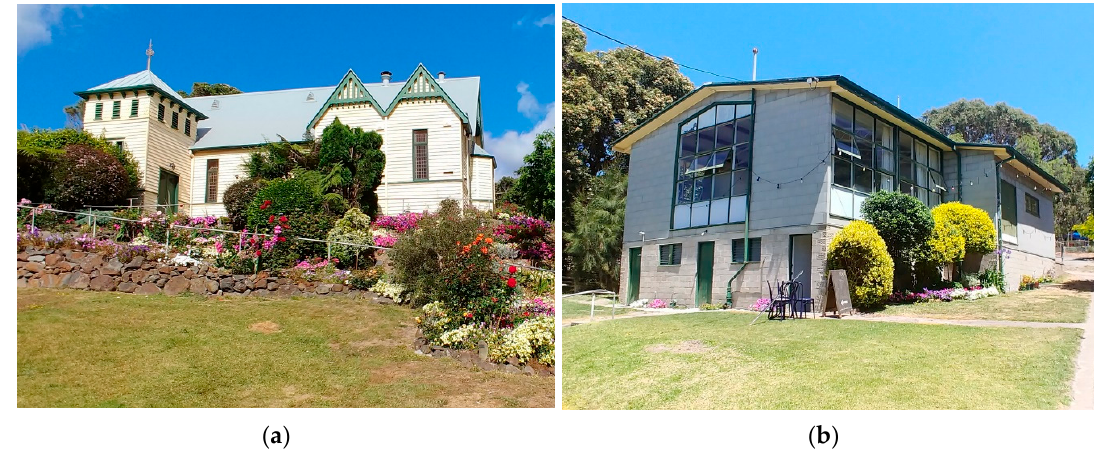
Figure 5. Photos of the Uniting Church’s Mountjoy Parade, Lorne, properties. ( a ) St. Cuthbert’s Church. ( b ) The Hall. Source: authors.